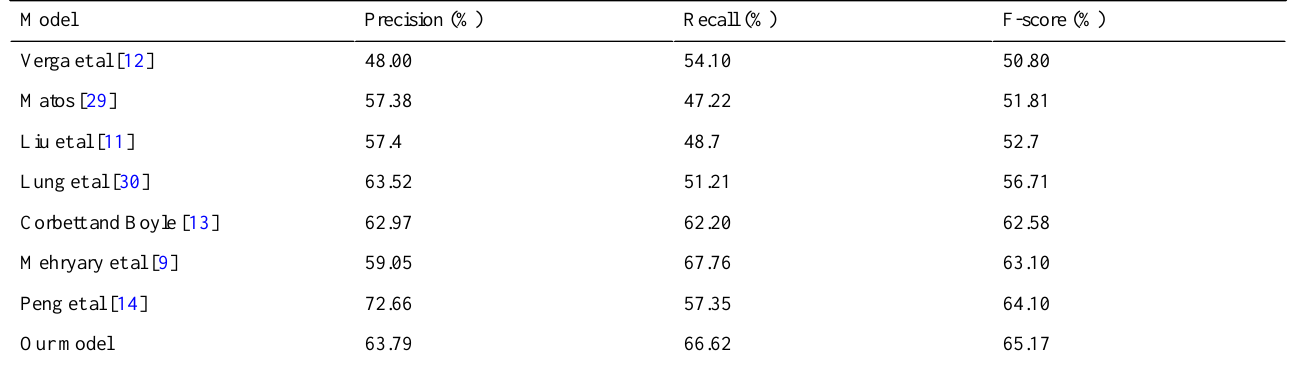
Table 6. Comparison with other existing